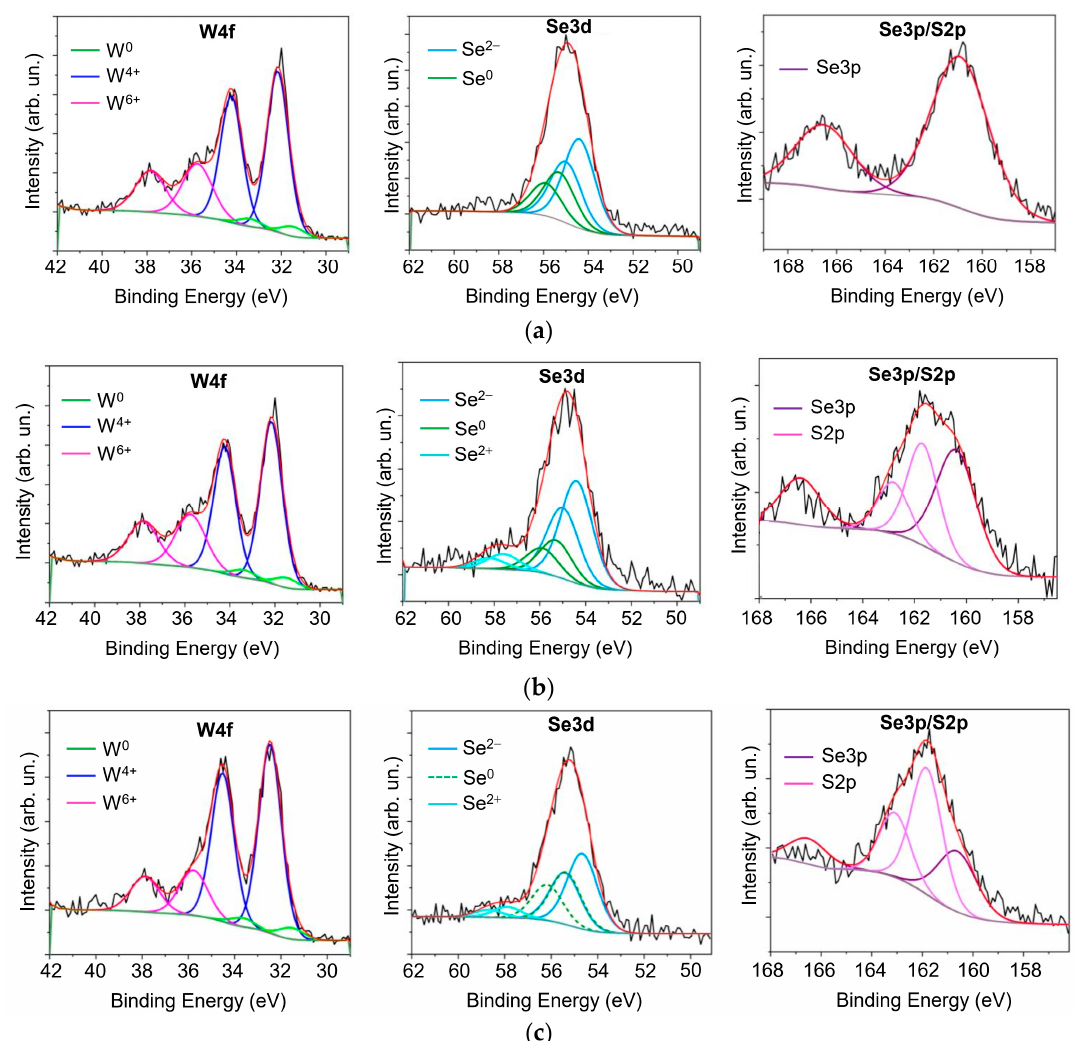
Figure 5. X-ray photoelectron spectroscopy scans of the ( a ) WSe x /NP-W, ( b ) WSe x S y /NP-W_3.6, and ( c ) WSe x S y /NP-W_9 coatings for the W, Se, and S elements. The XPS spectra of the WSe x S y /NP-W coatings reveal the presence of S2p peaks, along with Se3p peaks in the background. The Se3p peaks were analyzed using information obtained from the Se3p spectra of the pure WSe x /NP-W coating. The two peaks at 161.8 and 163.0 eV shown in the XPS spectra of the WSe x S y /NP-W coatings can be assigned to S2p 3/2 and S2p 1/2 binding energies, respectively [13,35]. The binding energies are independ- ent of the S concentration. In addition, two peaks assigned to Se2p 3/2 and Se2p 1/2 were ob- served at 160.9 and 166.6 eV, respectively.